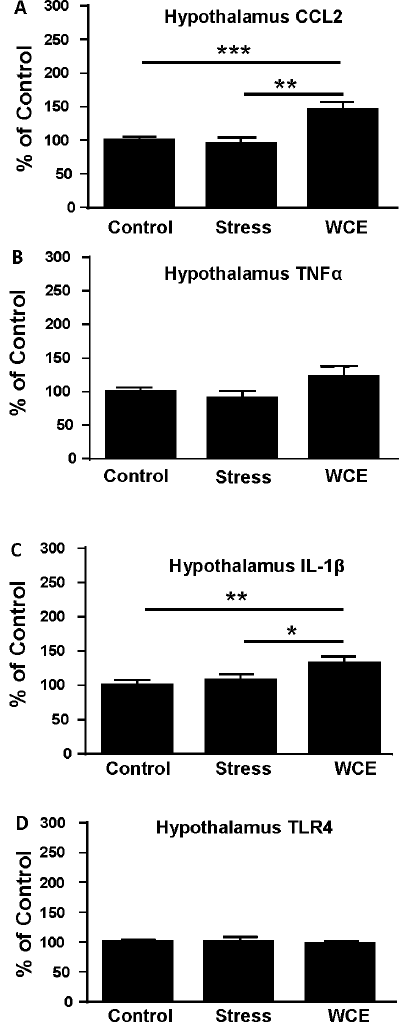
Figure 4. Effects of restraint stress or WCE on hypothalamic neuroimmune mRNAs. For CCL2, there